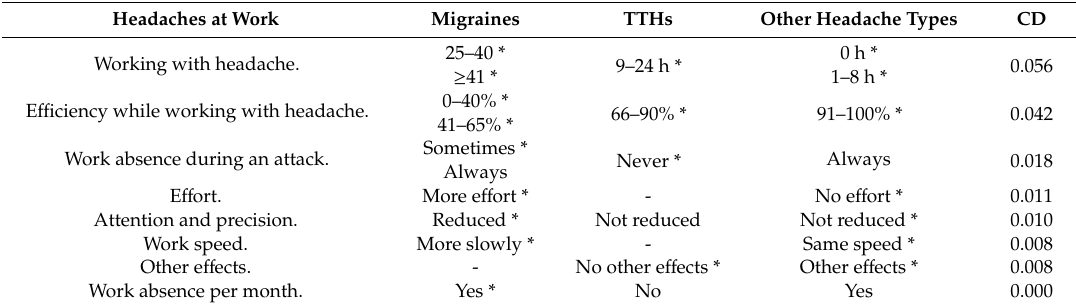
Table 3. Coe ffi cient of discrimination (CD) between studied headache types in relation to impact of headaches on work. Headaches at Work Migraines TTHs Other Headache Types CD Working with headache. E ffi ciency while working with headache. Work absence during an attack.